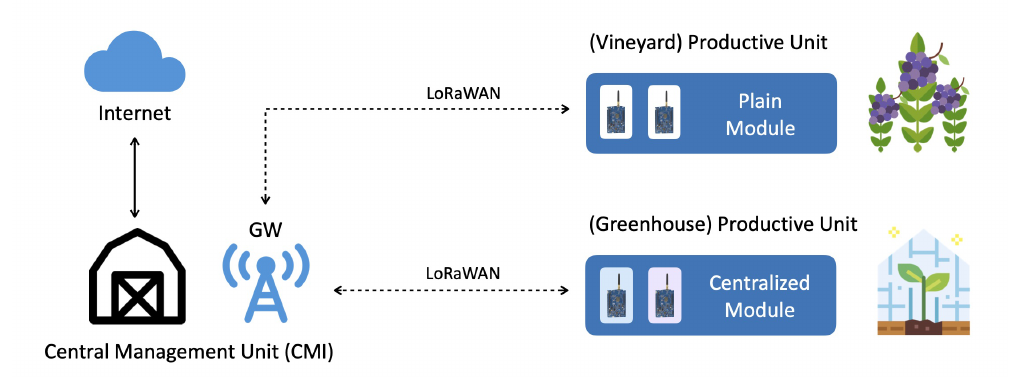
Figure 4. A farm organization based on “Units” (i.e., Central Management Unit, Productive Units), and the spatial distribution of the deployed farm modules and LoRaWAN